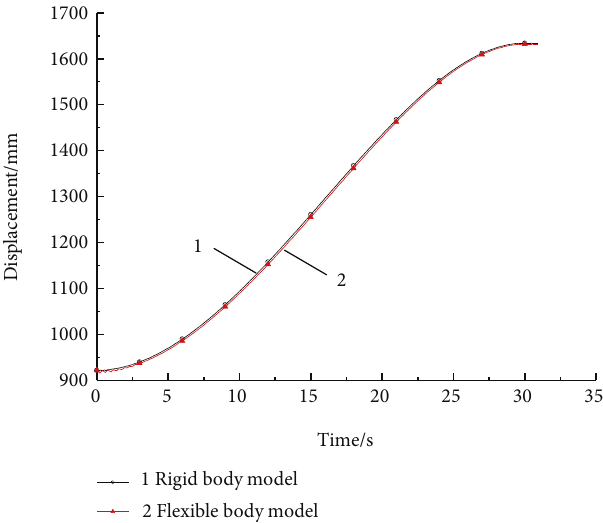
Figure 5: Patient transfer device tip displacement of di ff erent models.